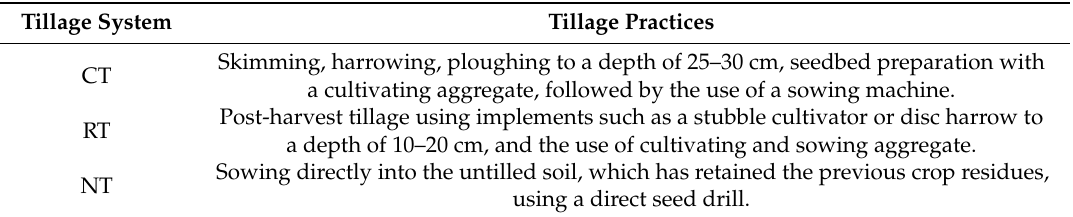
Table 2. Characteristics of tillage practices for winter wheat production under conventional tillage (CT), reduced tillage (RT), and no-tillage (NT) systems of the studied farms.